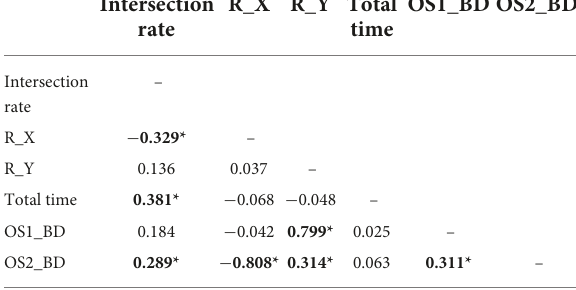
TABLE 3 Spearman’s ρ correlation between the